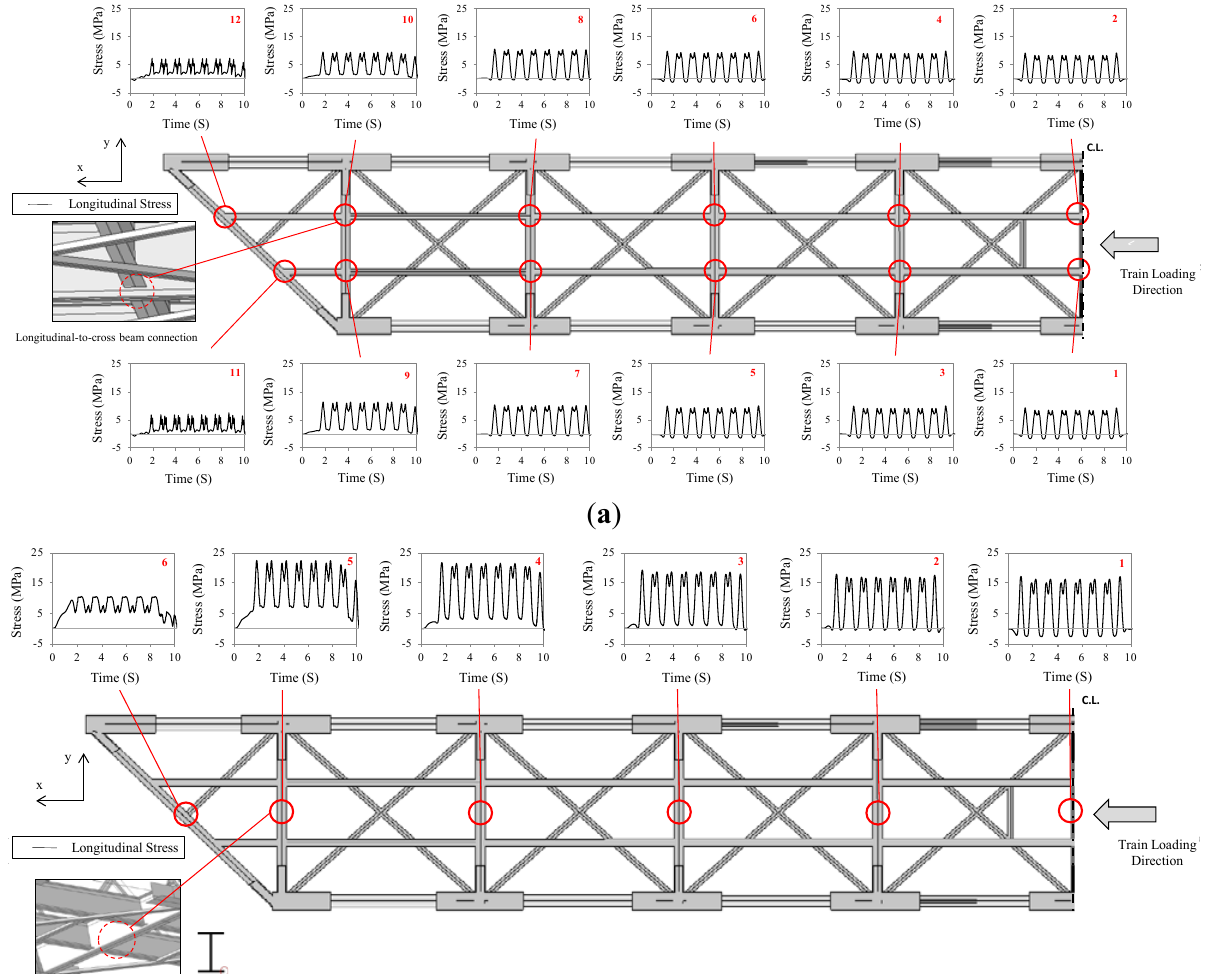
Figure 14. Stress range due to ICN train load model at ( a ) Longitudinal-to-cross girders (longitudinal stress, σ mid-span (longitudinal stress, σ yy